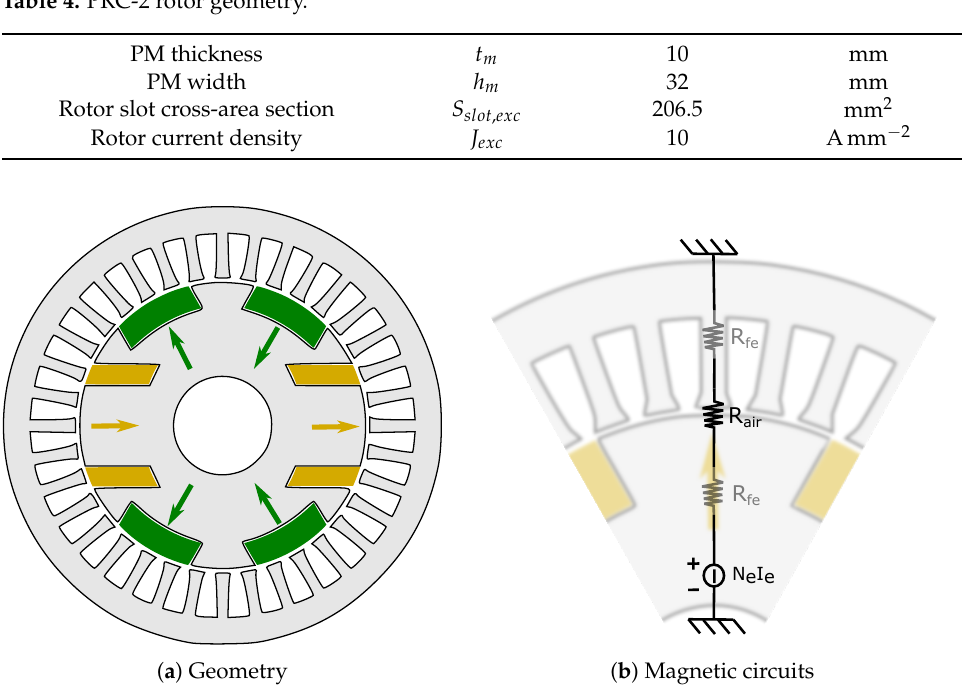
Table 4. PRC-2 rotor geometry.